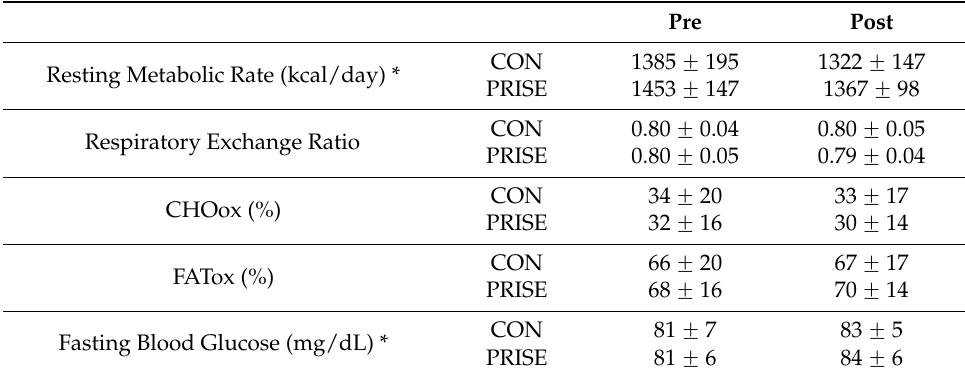
Table 4. Metabolic profile pre- and